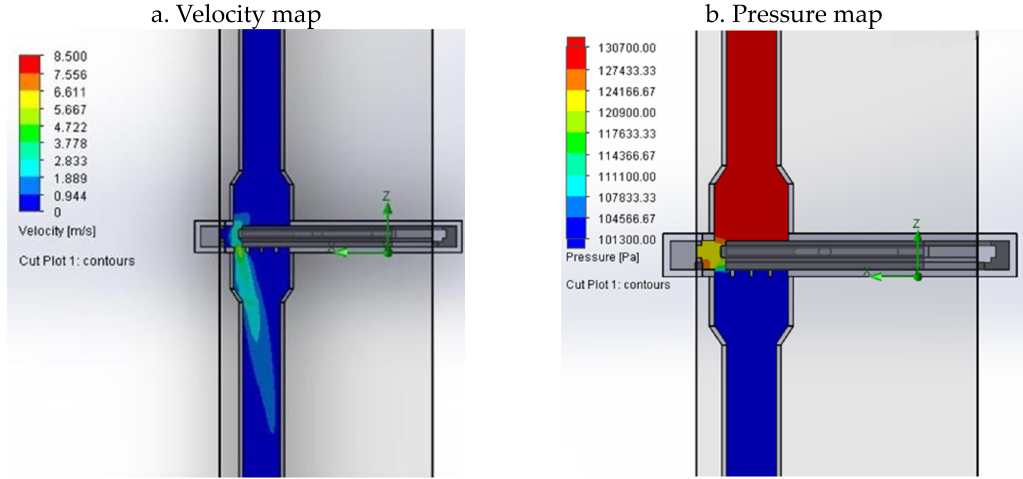
Figure 10. Second valve geometry with 10% opening.